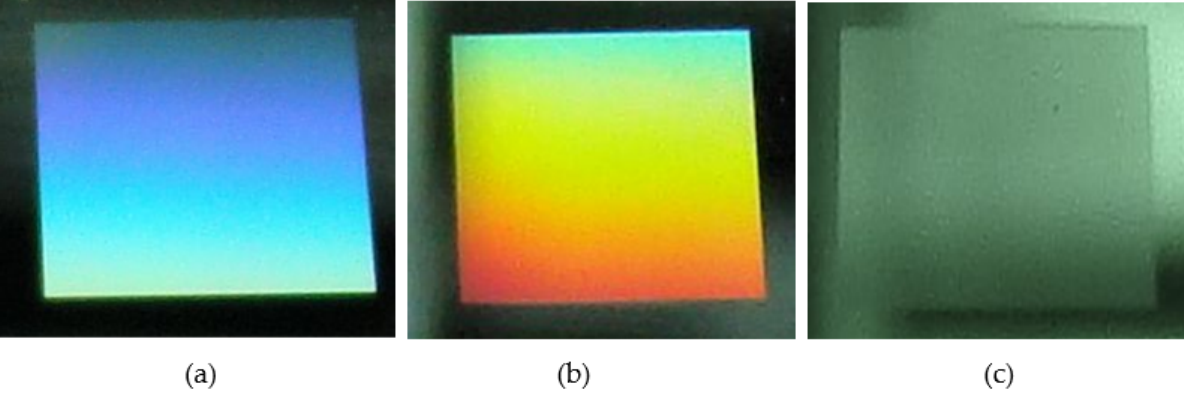
Figure 3. Photographs of ( a ) 500H, ( b ) 500H-P(MAA-DB) and ( c ) 500H-P(MAA-DB)-BDA.